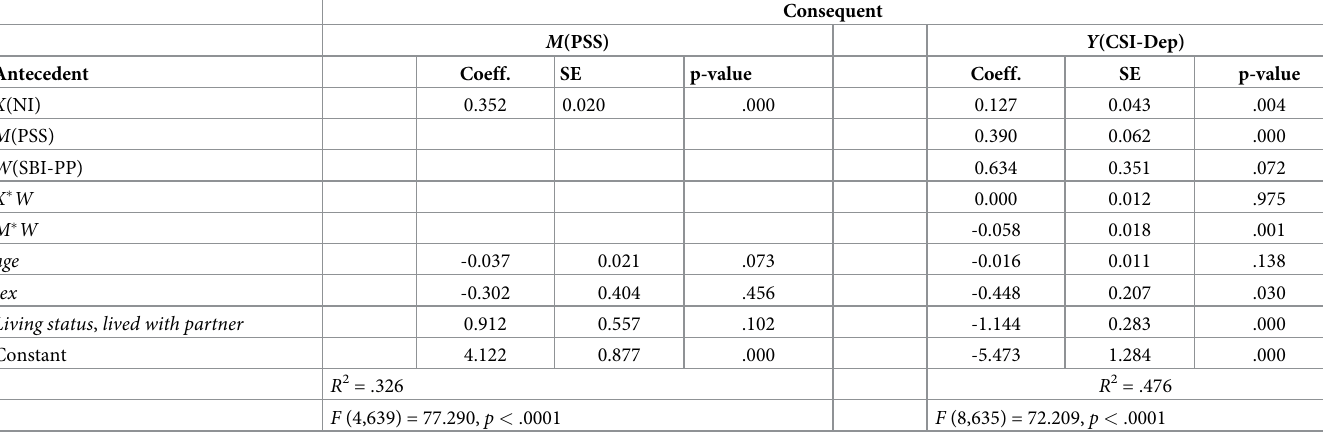
Table 4. Conditional indirect effect of neuroticism on depressive symptoms at values of the moderator observance of Five the Precepts through perceived stress. Consequent M (PSS) Y (CSI-Dep) Antecedent Coeff. SE p-value Coeff. SE p-value 0.352 .000 0.127 .004 .000